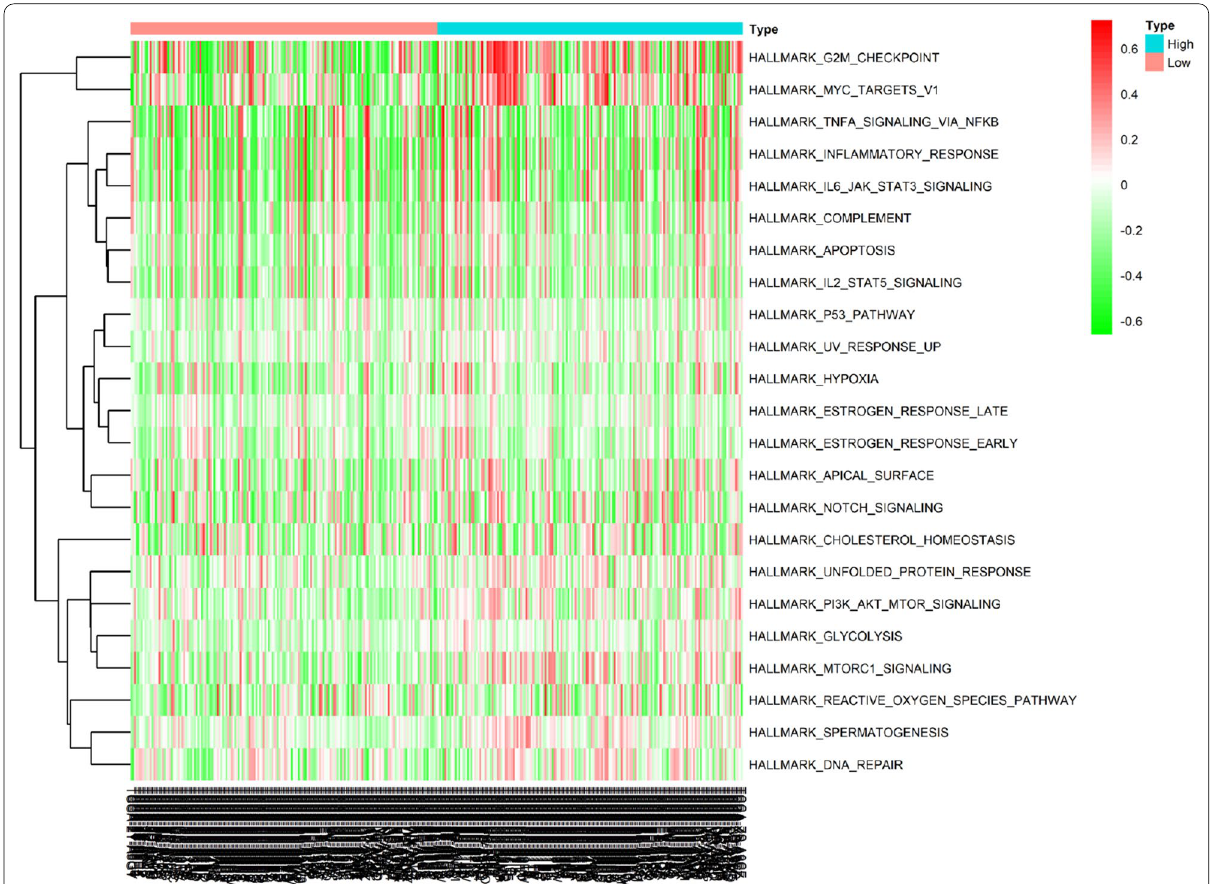
Fig. 9 Differences in biological behaviors between the high- and low-risk subgroups evaluated by GSVA. The top 23 biological processes with significant differences are visualized by a heatmap. Red represents activated pathways, and green represents inhibited